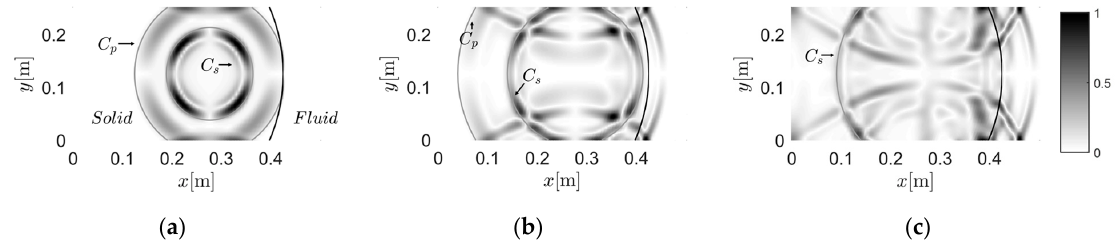
Figure 6. Snapshots of the wavefield induced by the source at 0.275 m and 0.125 m in the solid region: ( a ) 25 µ s, ( b ) 37.5 µ s, and ( c ) 50 µ